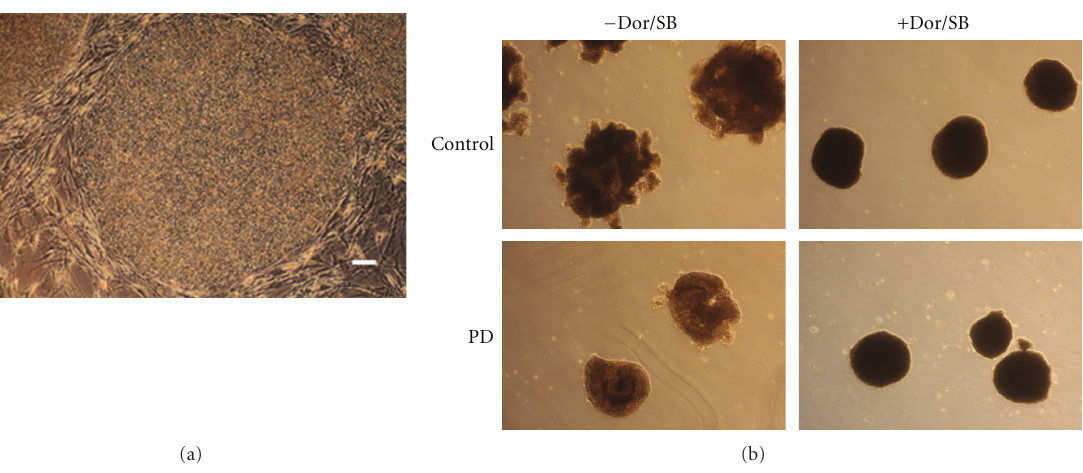
Figure 2: (a) Representative image of the quality of iPSC colonies used to produce EBs: distinct border with little to no di ff erentiation. The recommended size for EB formation should be double the size as the depicted colony, approximately 2 mm in diameter. Scale bar 100 μ m (b) In-control and PD-specific cell lines (Control and PD), EBs were lacking that compact structure and round borders when cultured without Dor/SB; EBs were found to be round, uniform in the presence of